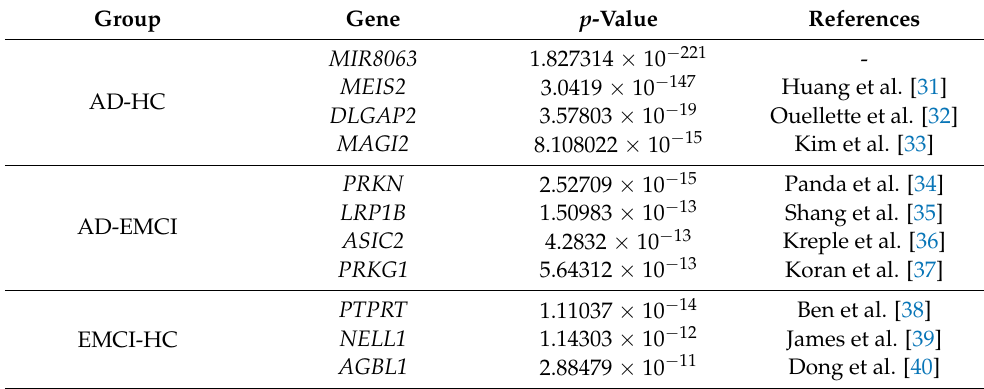
Table 4. Significant specific genes in each group.